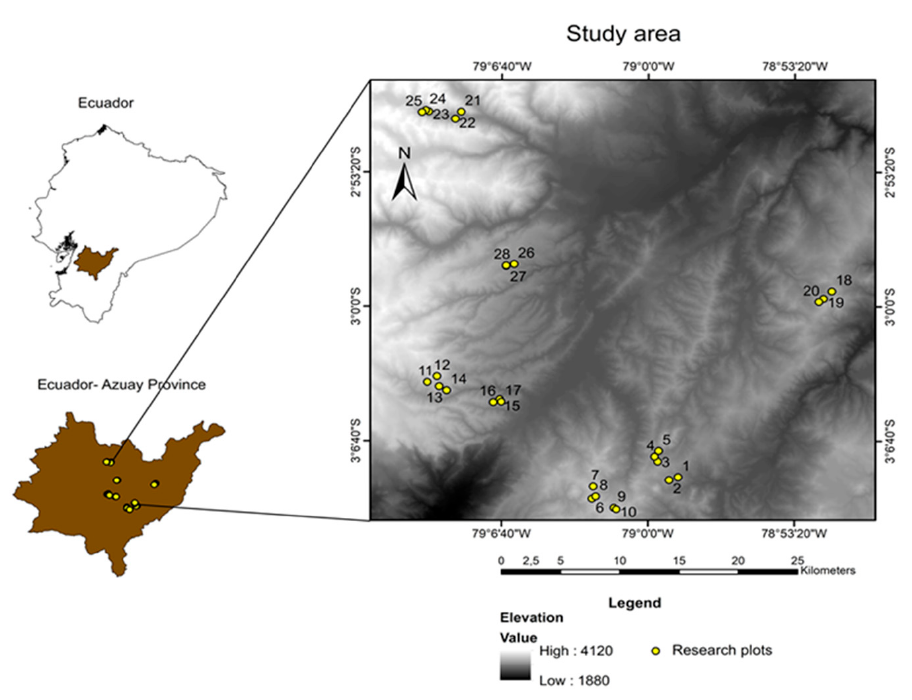
Figure 1. Plot placement and geographic location of study area in southern Ecuador. Plots were sampled from October 2016 to October 2017. In each plot, diameter at breast height (DBH) and total height of all trees with diameters DBH ≥ 10 cm were measured. The total height was calculated through the average of all the trees in the plot. The dominant height was calculated through the average of the 10 tallest trees in each plot. Fern trees with DBH ≥ 10 cm were also included in our database. All individuals were taxonomically identified at the species level directly in the field or by comparison with the specimens of the Loja herbarium (LOJA).